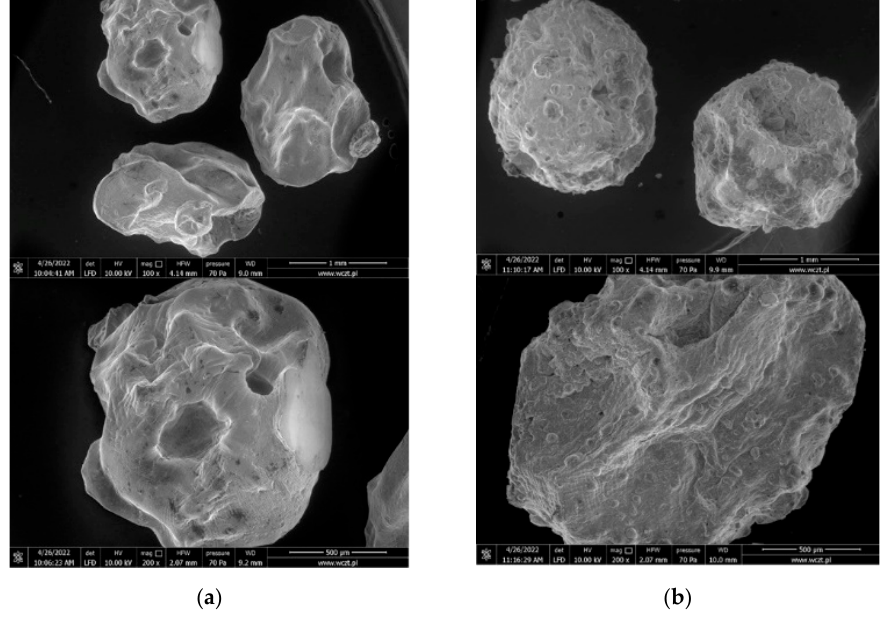
Figure 5. Scanning electron micrographs of alginate capsules without gemini surfactant: ( a ) Al@empty; ( b ) Al@empty+BaSO 4.